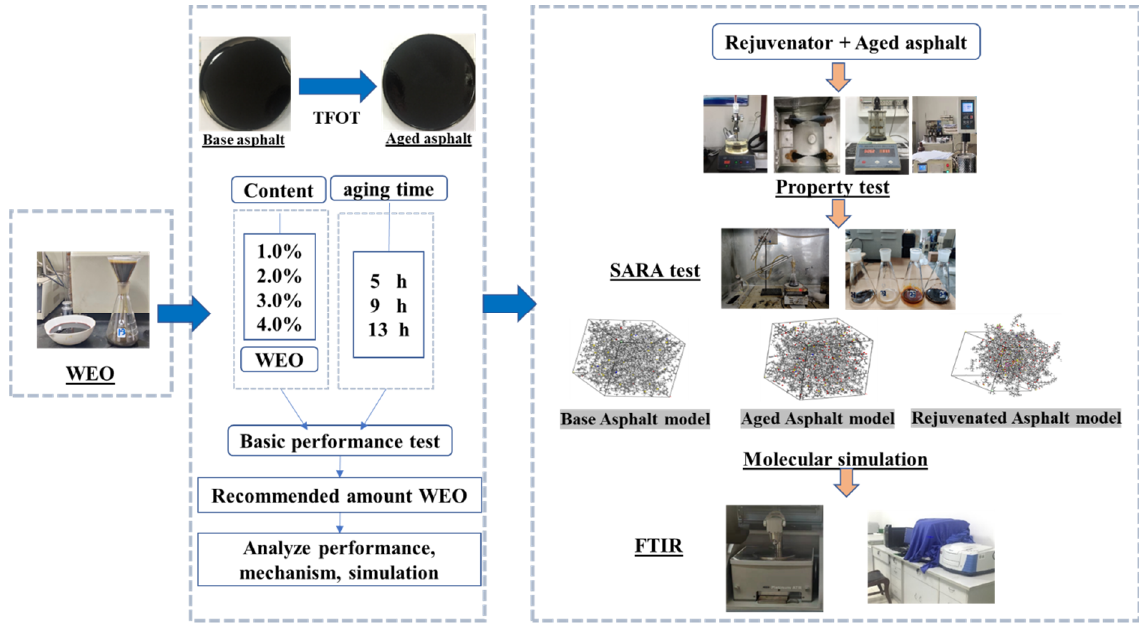
Figure 2. Technical route.